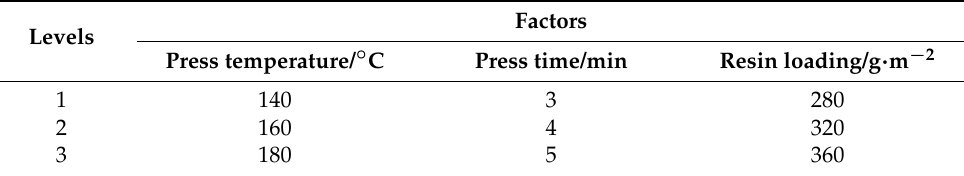
Table 1. Orthogonal experiment